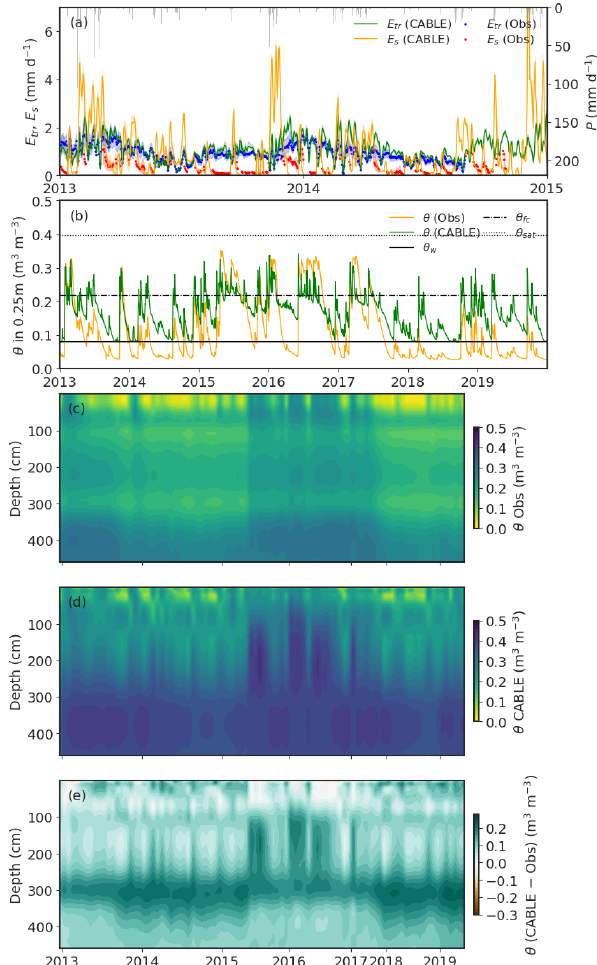
Figure 2. Control simulation (Ctl). (a) E tr ,E s and precipitation ( P ) between 2013 and 2015. The shaded areas represent uncertainty be- tween three ambient rings. Both simulations and observations are smoothed with a 3d window to aid visualisation. (b) θ in the top 0.25m from 2013 to 2019. (c) The vertical distribution of θ mea- sured at observed dates from 2013 to 2019. (d) The vertical dis- tribution of θ in Ctl for observed dates from 2013 to 2019. (e) θ differences between CABLE and observations. Note the different time axis for panels (c–e) relative to panels (a, b) due to different sampling intervals for soil moisture and